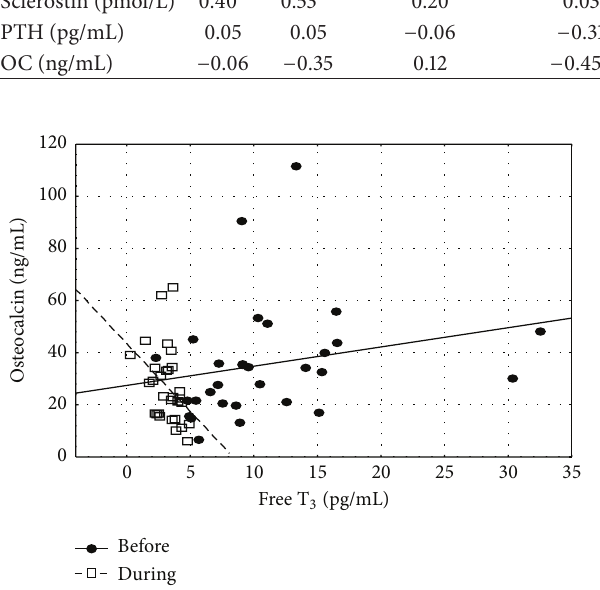
Table 4: Spearman rank correlation coefficients after therapy. Analysis of association: significant correlations are marked with asterisks: ∗ 𝑝 < 0.05 , ∗∗ 𝑝 < 0.01 . OC, osteocalcin; CTX, collagen type I cross-linked C-telopeptide. After treatment Sclerostin (pmol/L) 0.40 ∗